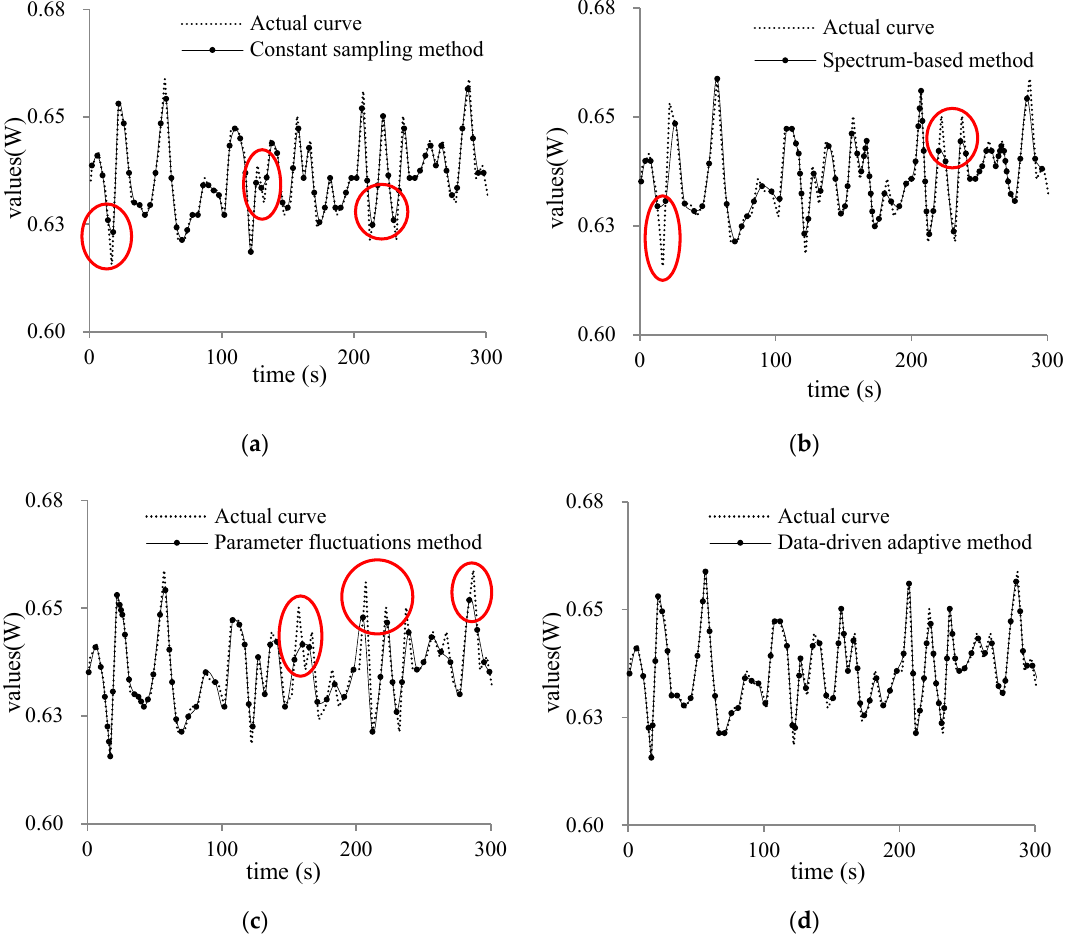
Figure 9. ( a ) constant sampling curve of power; ( b ) spectrum-based curve of power; ( c ) parameter fluctuations curve of power; ( d ) data-driven adaptive curve of power.